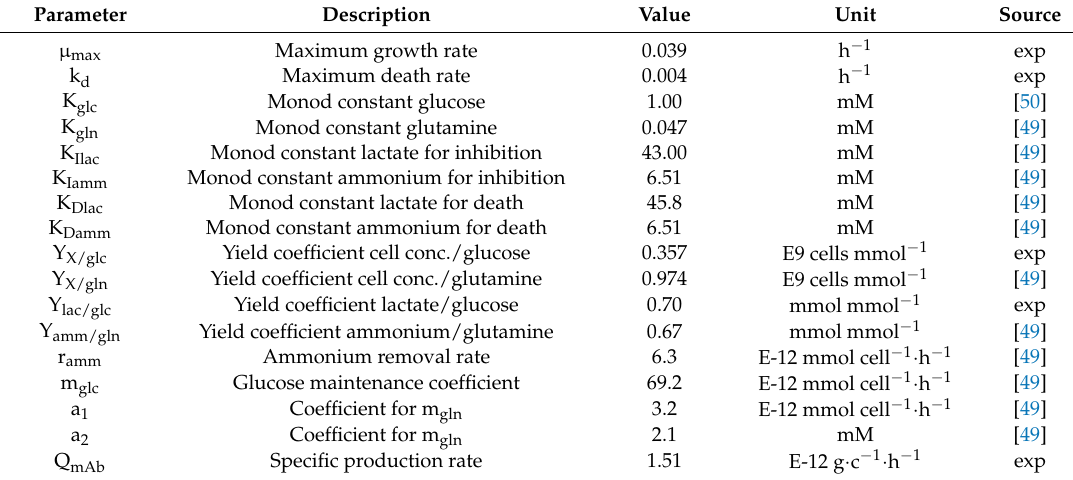
Table 2. Model parameters used in the macroscopic Monod model for the simulation of CHO cultivations based on literature (Lit.) or experimental data (exp). Literature data were determined using fed-batch CHO cell culture and the markov chain monte carlo method for parameter estimation [49] or by the differential evolution technique